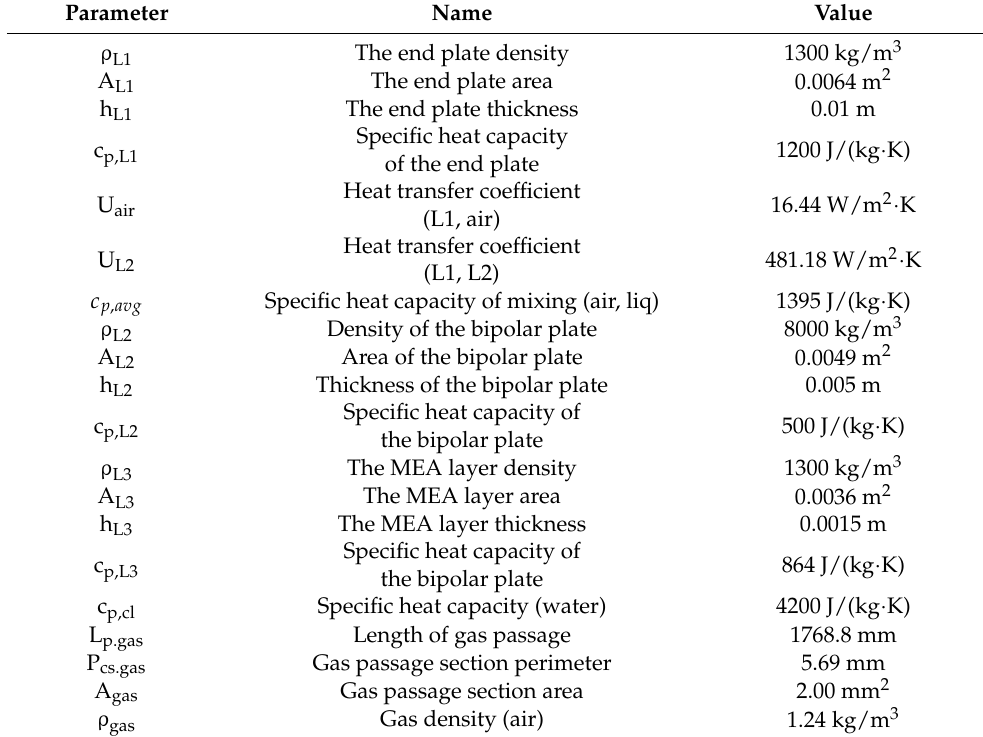
Table 1. Parameter